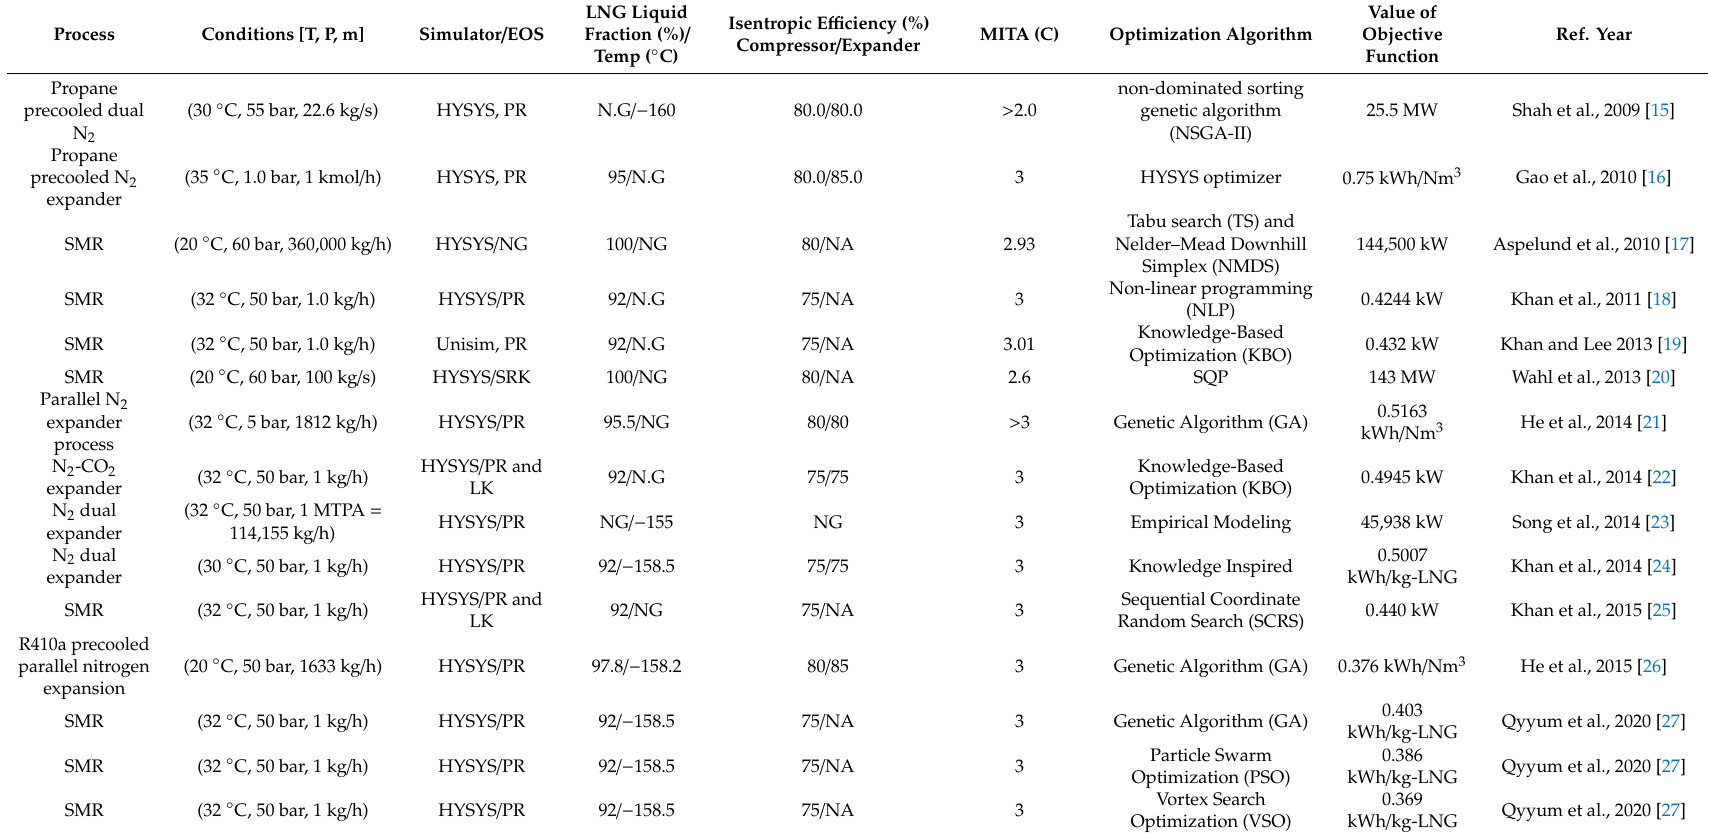
Table 2. Literature survey on design optimization of single mixed refrigerant (SMR) and N 2 expander LNG